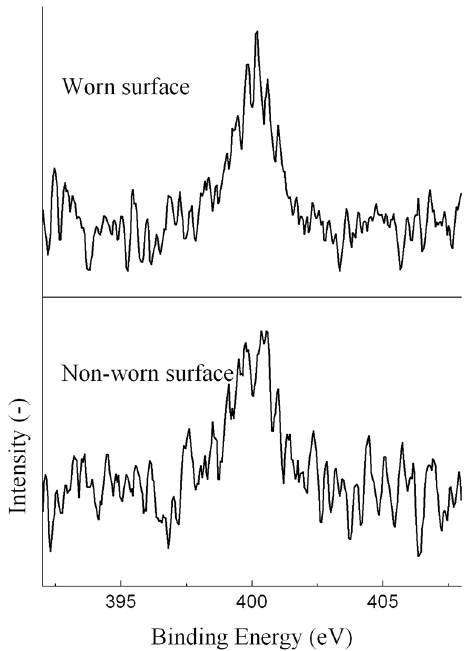
Figure 7. N 1s XPS spectra of the ball lubricated with the